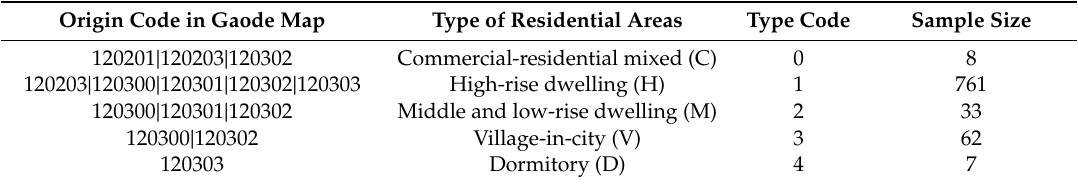
Table 2. A look-up table for residential types adopted in this study and original type codes in Gaode Map point of interest (POI) data.